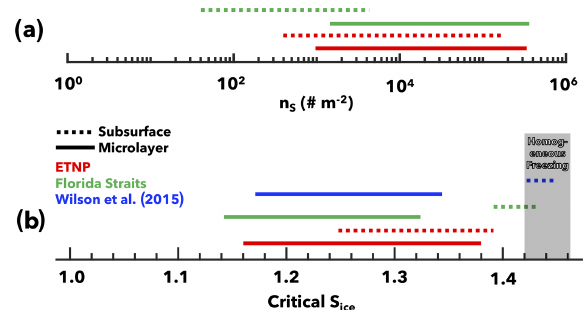
Figure 6. Ice nucleation activity comparison. (a) The INP active site density in the immersion mode, and (b) critical supersaturation required to attain 1% fractional activation in the deposition mode. Subsurface samples from the ETNP were more effective INPs than subsurface samples from less productive marine environments like the Florida Straits and the North Atlantic (Wilson et al.,